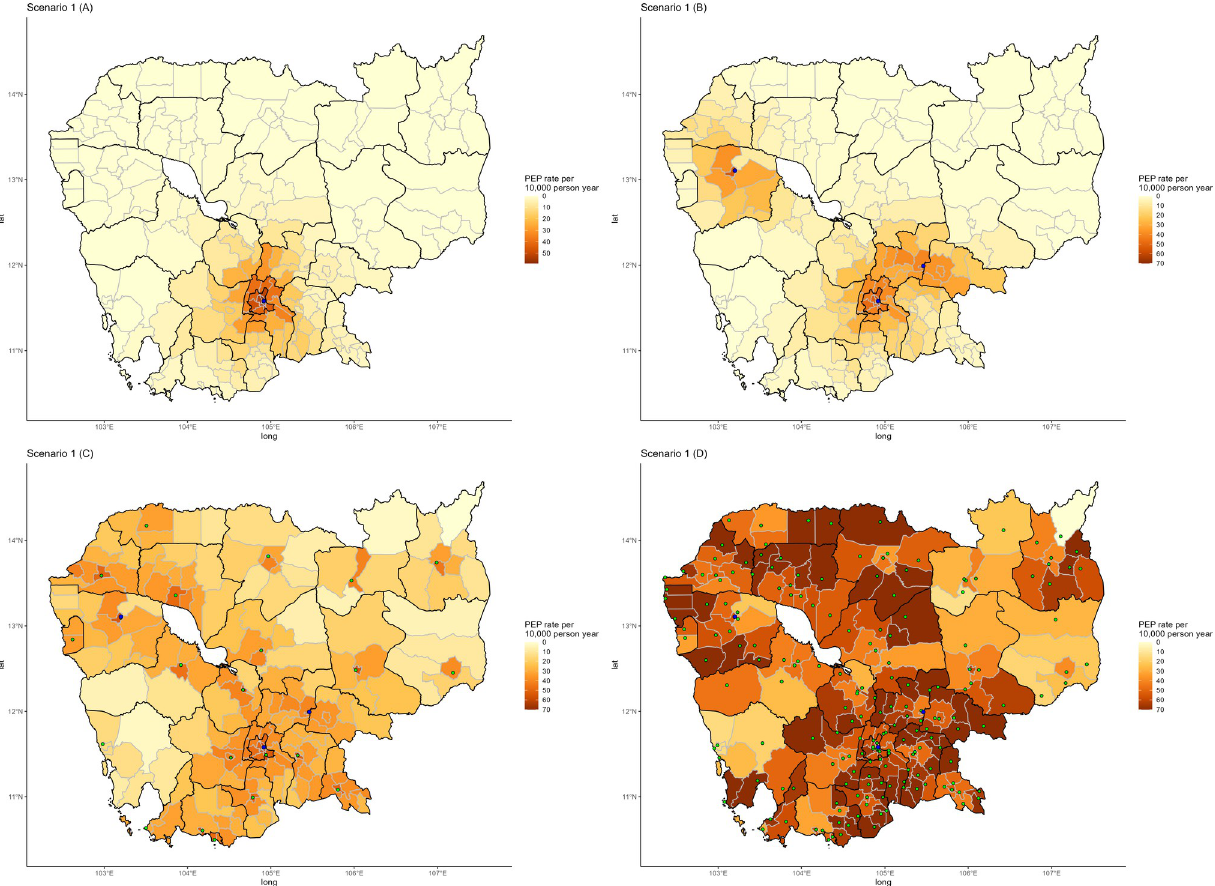
Fig 4. Predictions of the rate of PEP patients in the population for the year 2017 based on three scenarios. (A) Scenario 1 represents the situation prior to the opening of new centers in Battambang and Kampong Cham provinces with a single center in Phnom Penh. (B) Scenario 2 represents the current situation, with the opening of two new centers in Battambang and Kampong Cham provinces that actually opened in 2018 and 2019 respectively, bringing the total number of centers to three. (C & D) Scenario 3 and 4 represens the theoretical opening of a center in every provincial capital and district capital respectively. Blue dots represent currently existing centers as of 2020, green dots represent provincial or district capitals where future centers could be opened. Base map can be found at [45]. https://data.humdata.org/dataset/cambodia-admin-level-0-international-boundaries. Details for the corresponding license can be found at: https://data.humdata.org/faqs/licenses.